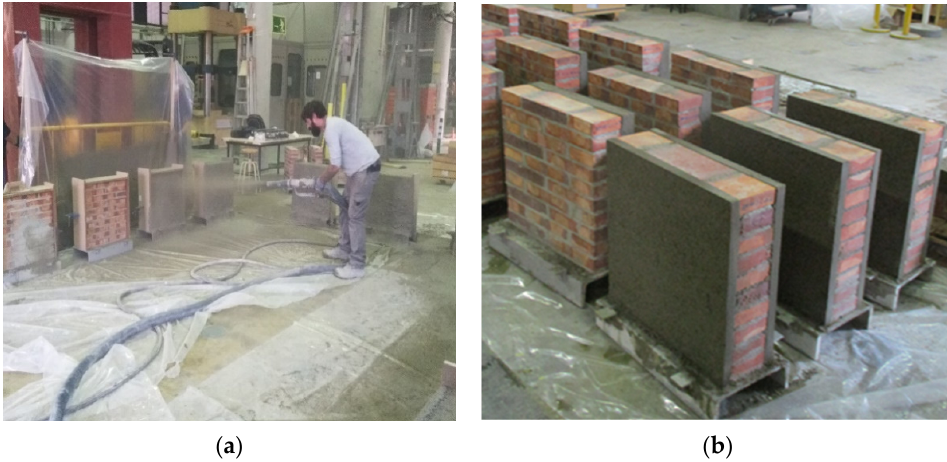
Figure 2. Sample preparation process: ( a ) The construction process of spraying mortar on the wall sample; ( b ) Finished samples.